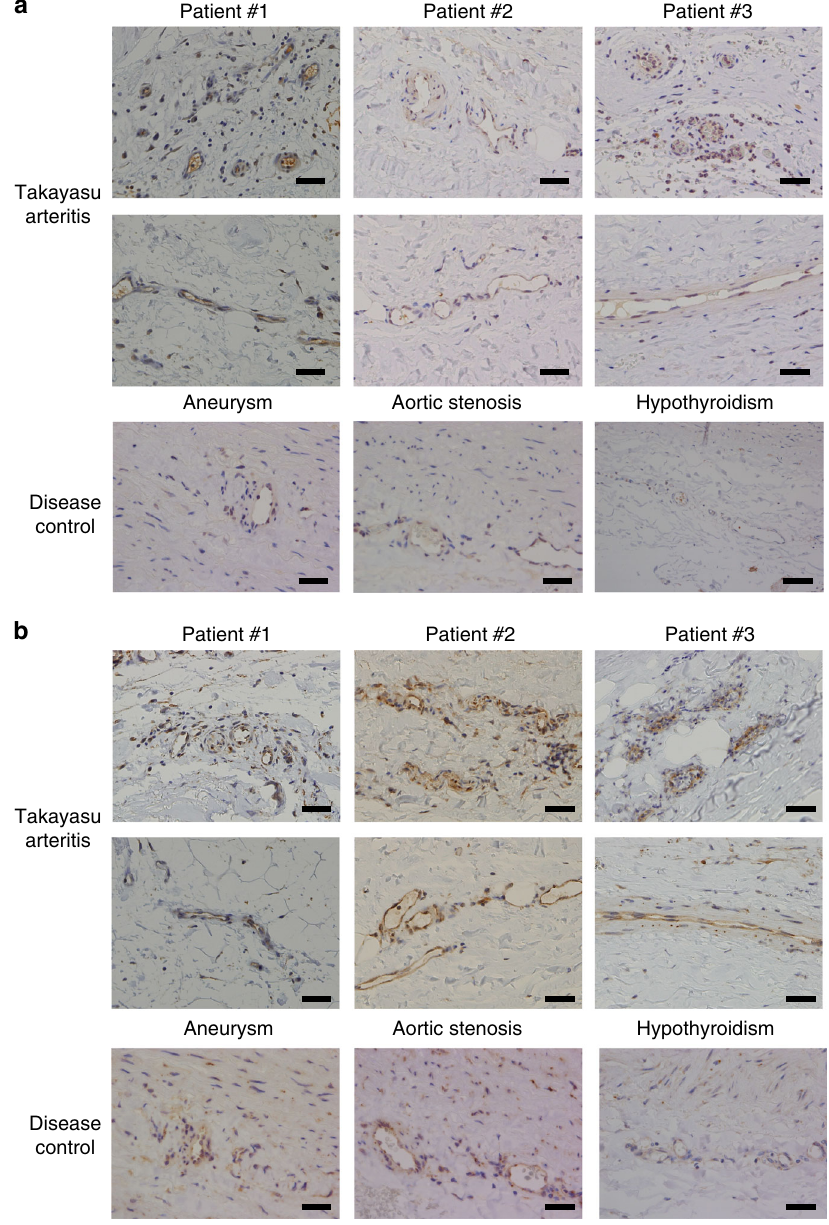
Fig. 3 Expressions of EPCR and SR-BI in the vasa vasorum of the aorta. Immunohistochemical analysis was performed against EPCR ( a ) and SR-BI ( b ) in resected aortic tissue from three different patients with TAK (upper two columns) and non-in fl ammatory aortic tissue as disease controls (lower column). Disease controls included surgical specimen from patients with aortic aneurysm and aortic stenosis, and an autopsy sample from a patient with hypothyroidism. Expressions in the vasa vasorum of the aorta are shown. Black bar indicates 40 µ